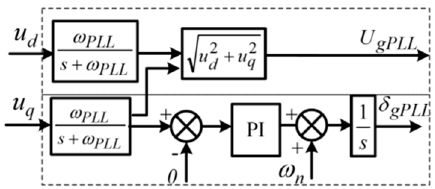
Figure 2. System of three-phase SRF-PLL.